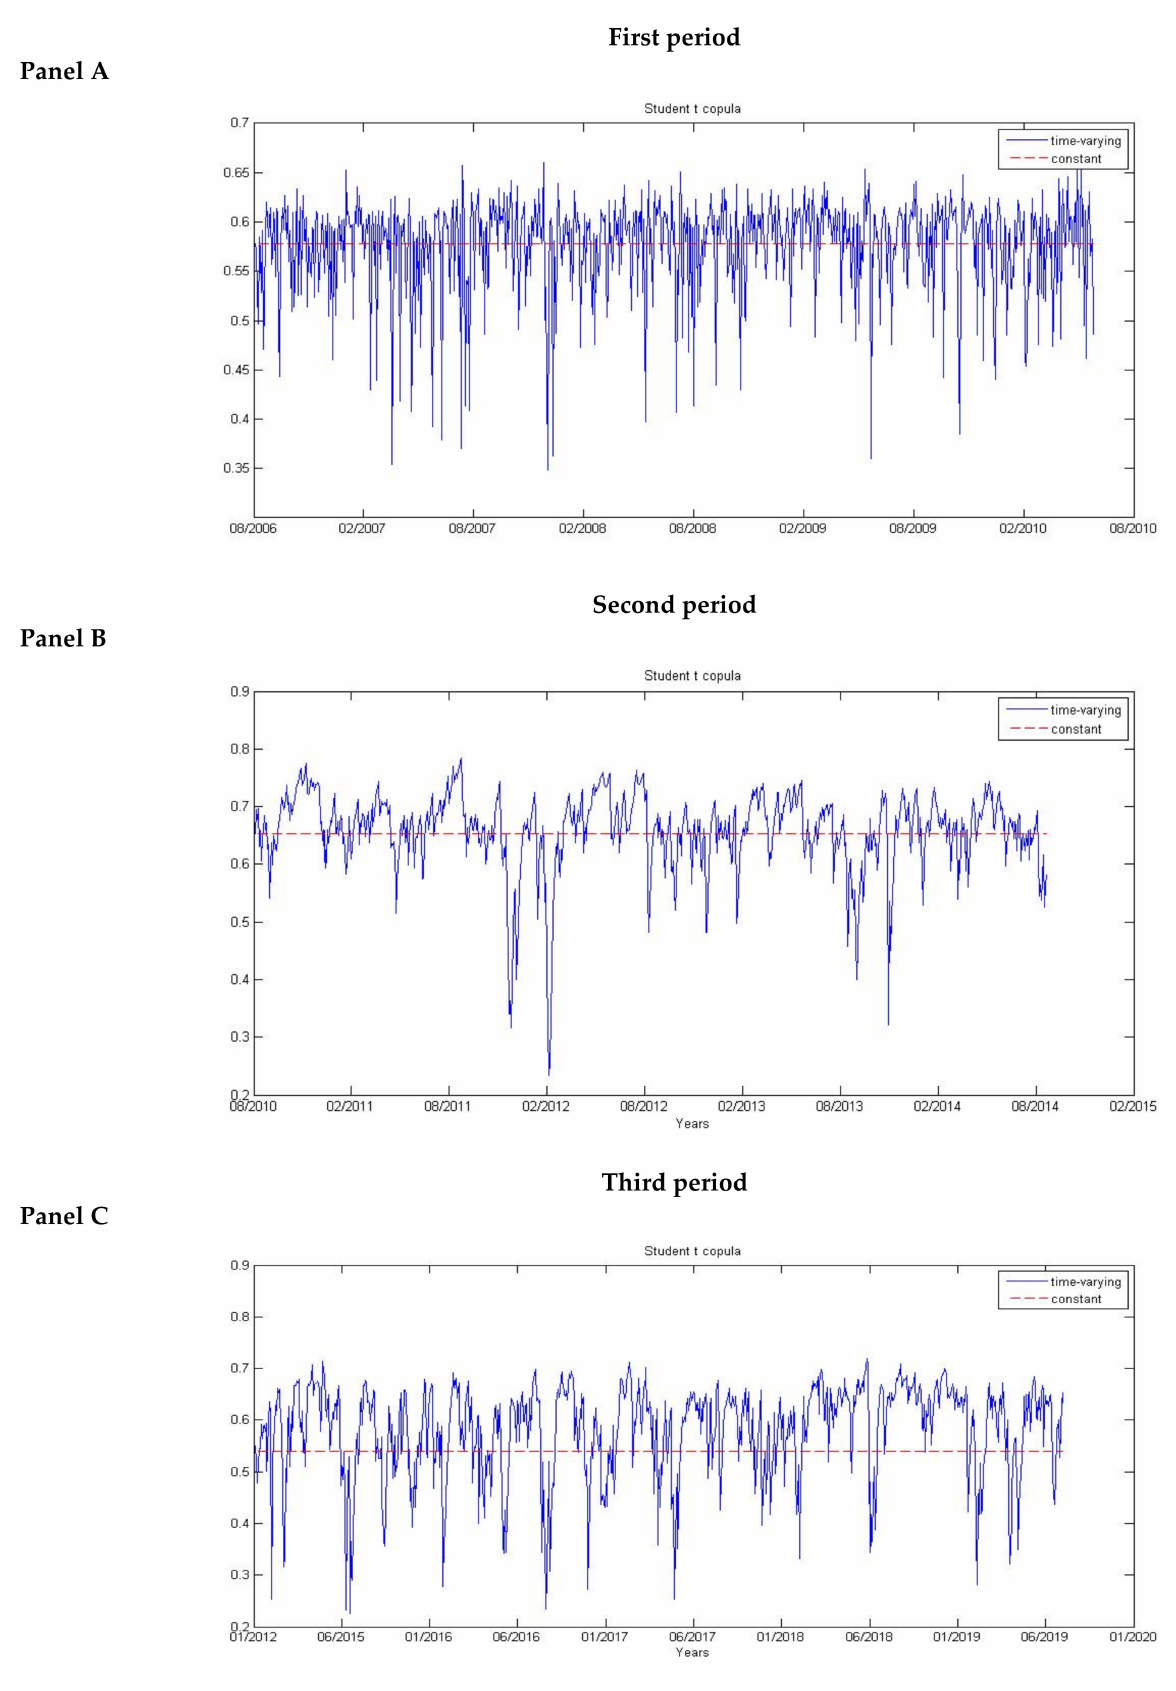
Figure 2. Time varying Student t copula for CBOT-MATIF price